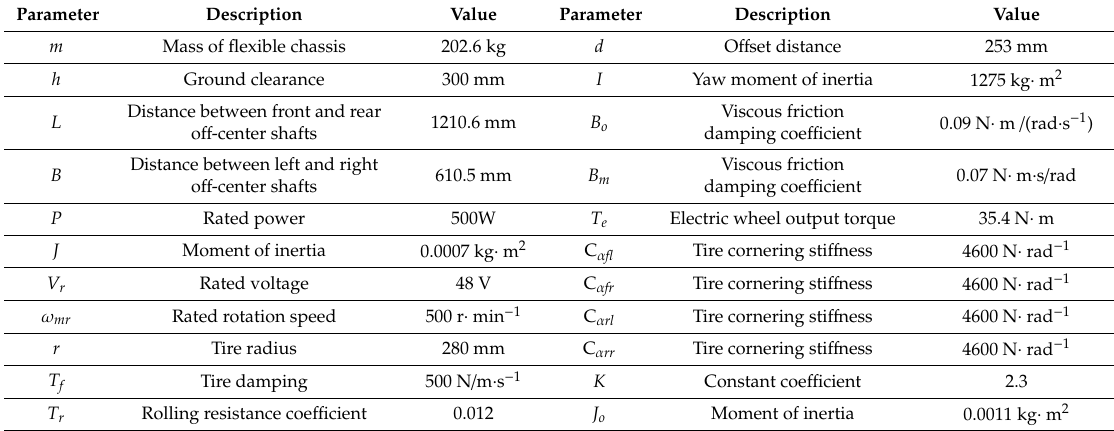
Table 2. Main FC motion mode switching (MMS) simulation parameters.